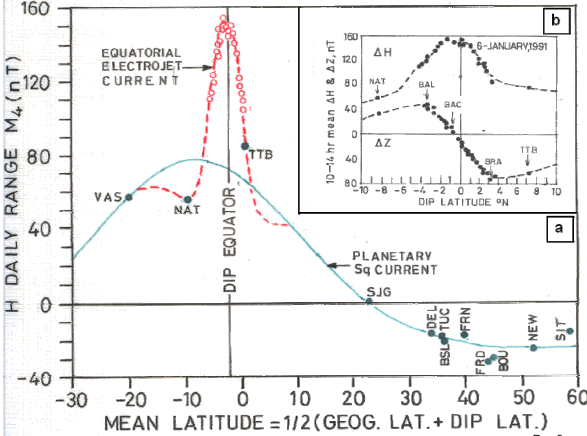
Fig. 3. Latitudinal variations of the four hourly (10–13) mean daily range M4 of H due to planetary and electrojet currents for 6 January 1991 (after Rigoti et al., 1999).